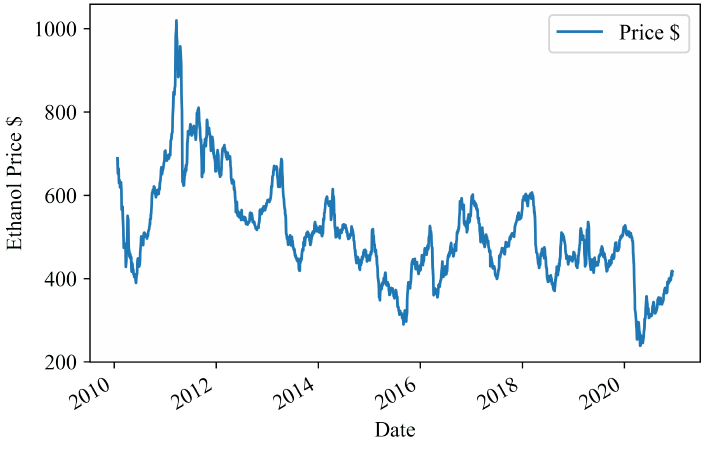
Figure 1. Brazilian Ethanol Spot Prices in U$ Dollars over the period between 2010 and 2020. Data Pre-Processing